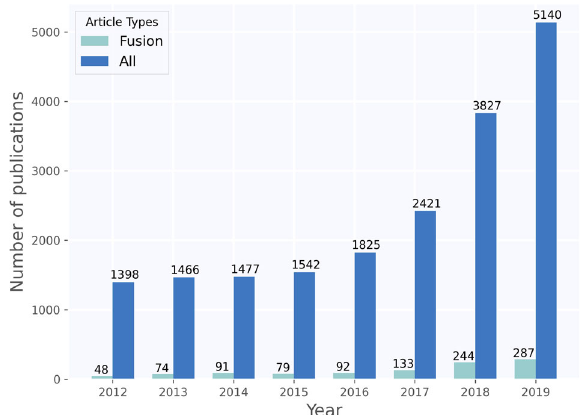
Fig. 1 Timeline of publications in deep learning for medical imaging. Timeline showing growth in publications on deep learning for medical imaging, found by using the same search criteria on PubMed and Scopus. The fi gure shows that fusion has only constituted a small, but growing, subset of medical deep learning